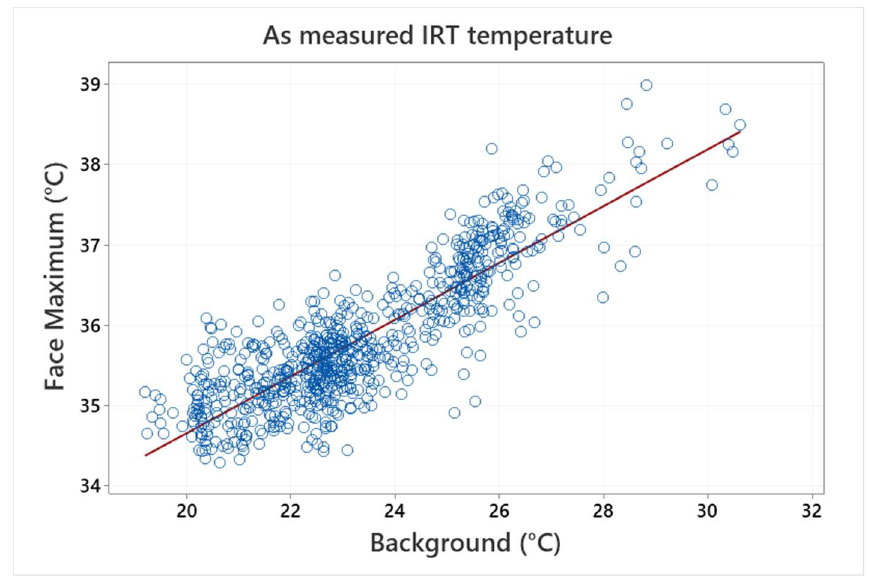
Figure 2. Dependence between IRT measured face temperature and background temperature without corrections—as measured values (symbols) and a linear regression (line) are shown.